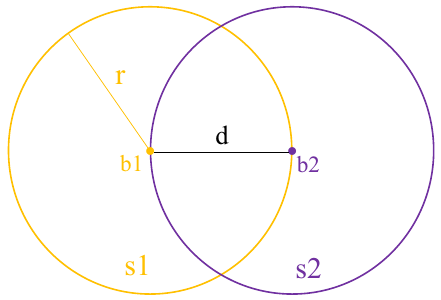
Fig. 7 Graphical representation of the normalized barycenter distance method. b 1 barycenter of the surface s 1 of the simulated sentinel lymph node visualized by augmented reality, b 2 barycenter of the surface s 2 of the simulated sentinel lymph node visualized in the endoscopic image, d the distance between the two barycenters b 1 and b 2 and r the theoretical radius of the surface s